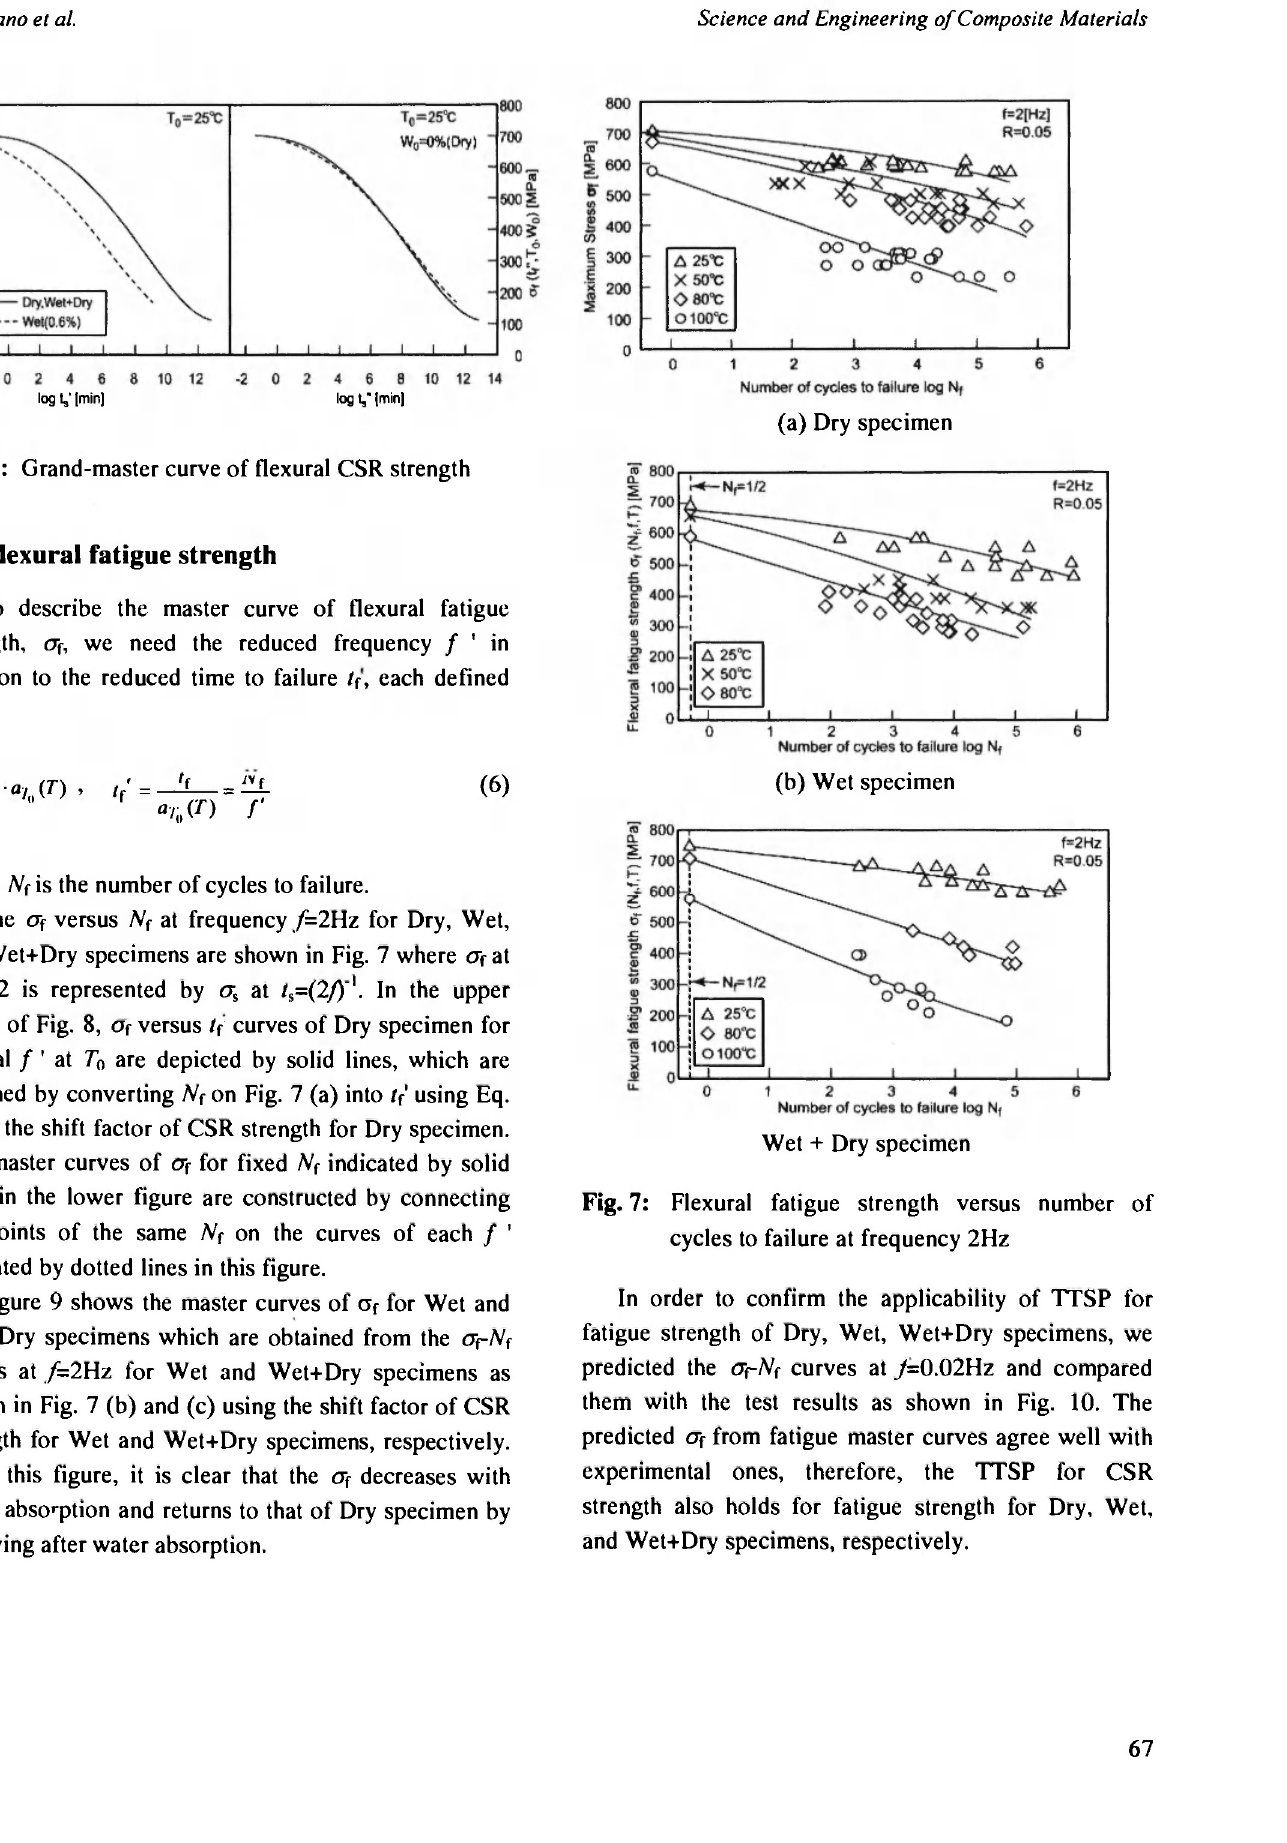
Fig. 6: Grand-master curve of flexural CSR strength